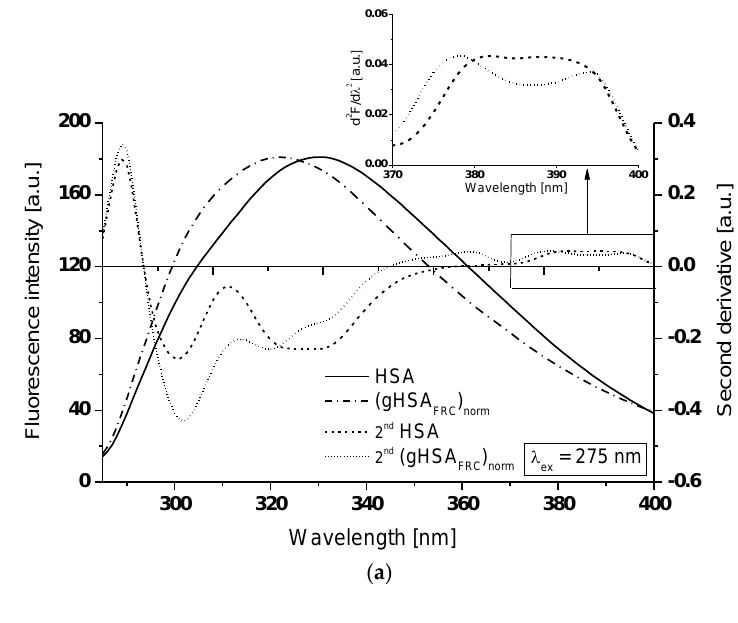
Figure 6. Cont . Figure 6.